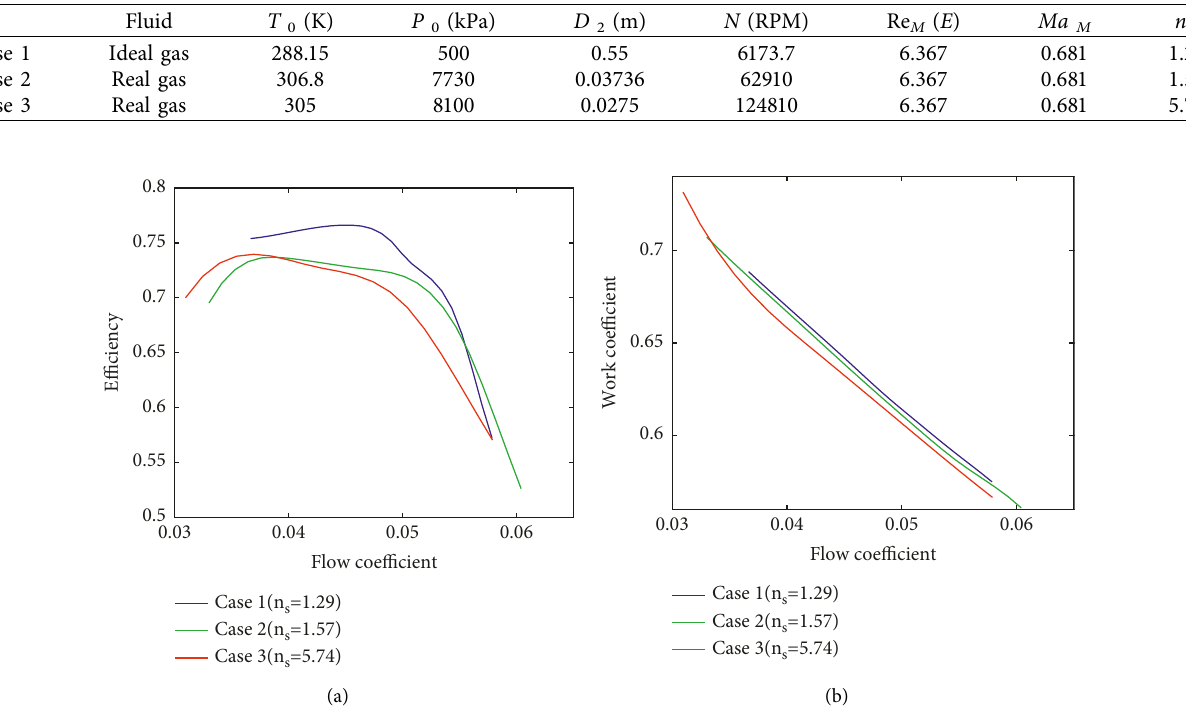
Figure 17: Dimensionless compressor characteristics. (a) Efficiency and (b) work